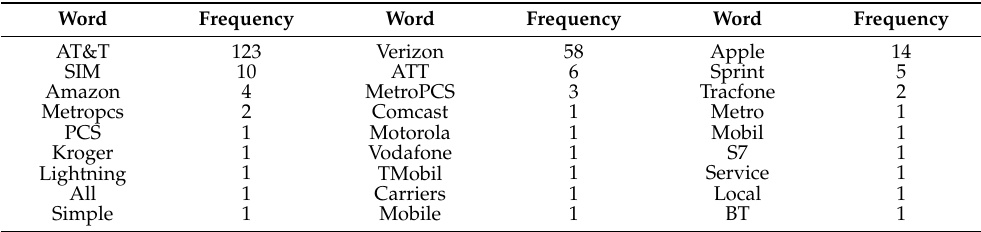
Table 13. Named-entity recognition result by